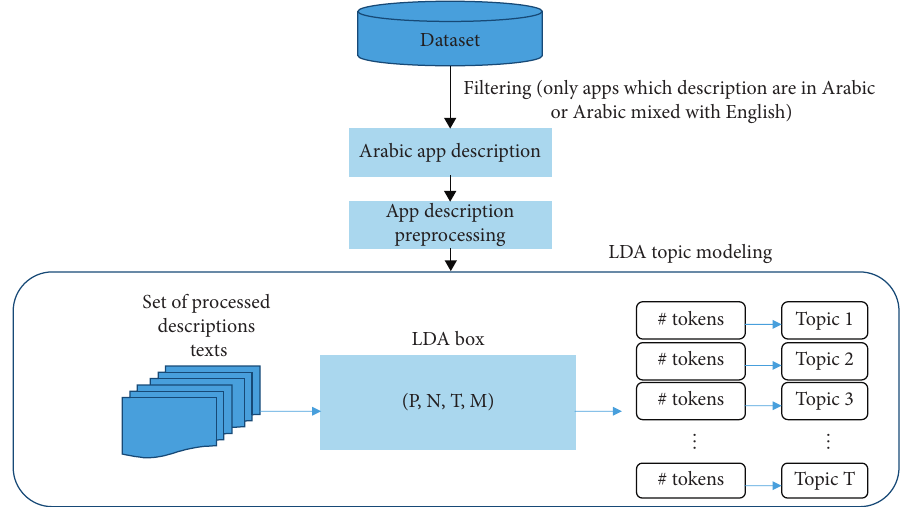
Figure 2: Arabic app classification using LDA